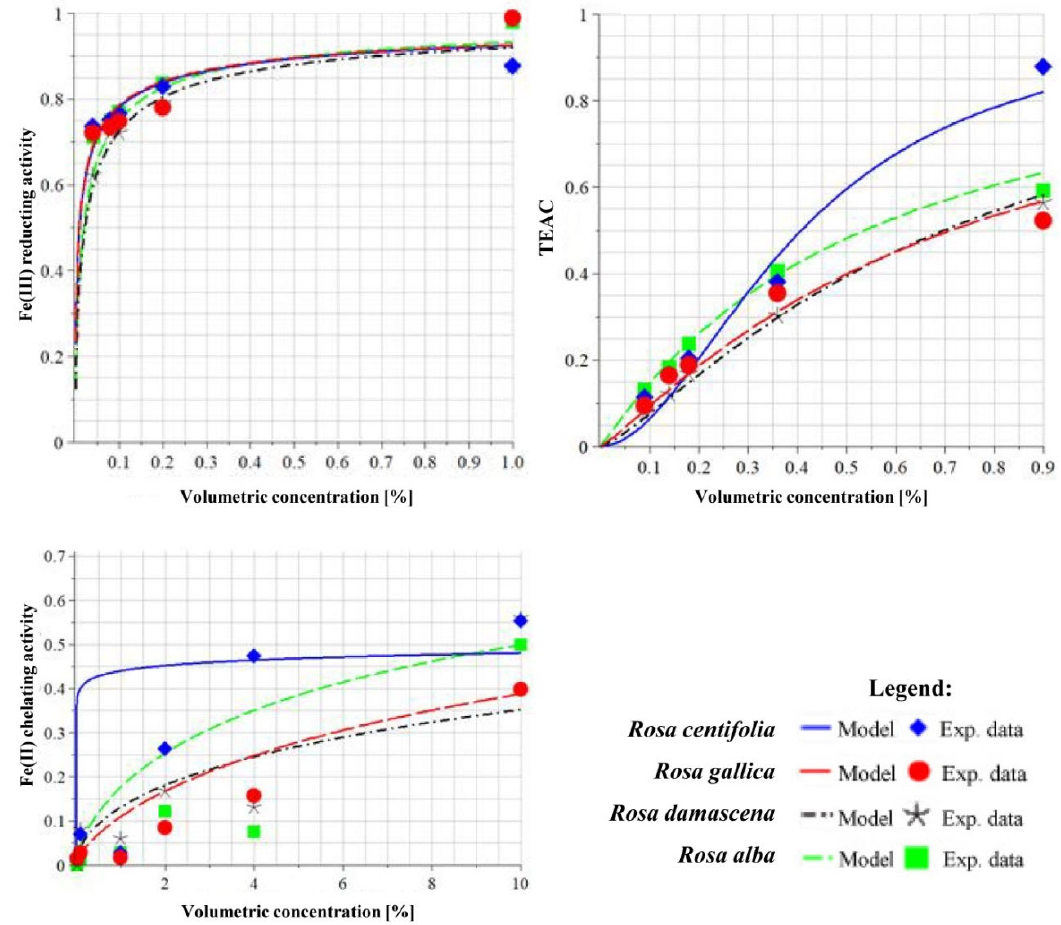
Figure 5. Quantitative evaluation through IC 50 values of the redox-modulating capacity of wastewater samples, using a nonlinear median effect model.